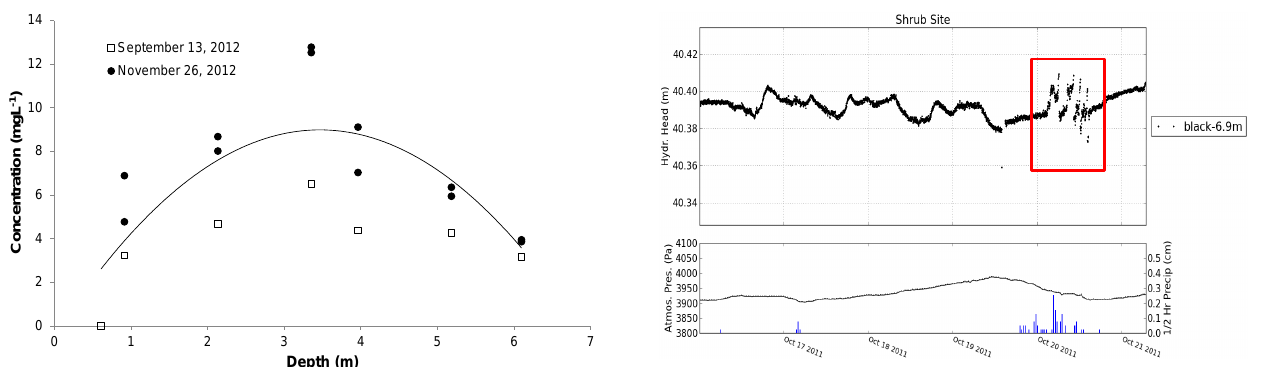
Fig. 5. CH 4 concentrations at the pools and esker site (ii). Data showed the highest average concentrations of CH 4 from all 4 sites. Data from 13 September and 26 November 2012 shows higher con- centrations at the approximate depth of the esker crest ( ∼ 3m), indi- cating increased CH 4 production at depth and possible hot spot pro- duction due to esker influence. The quadratic regression line shown is significant ( R 2 =0.47, p =0.002).